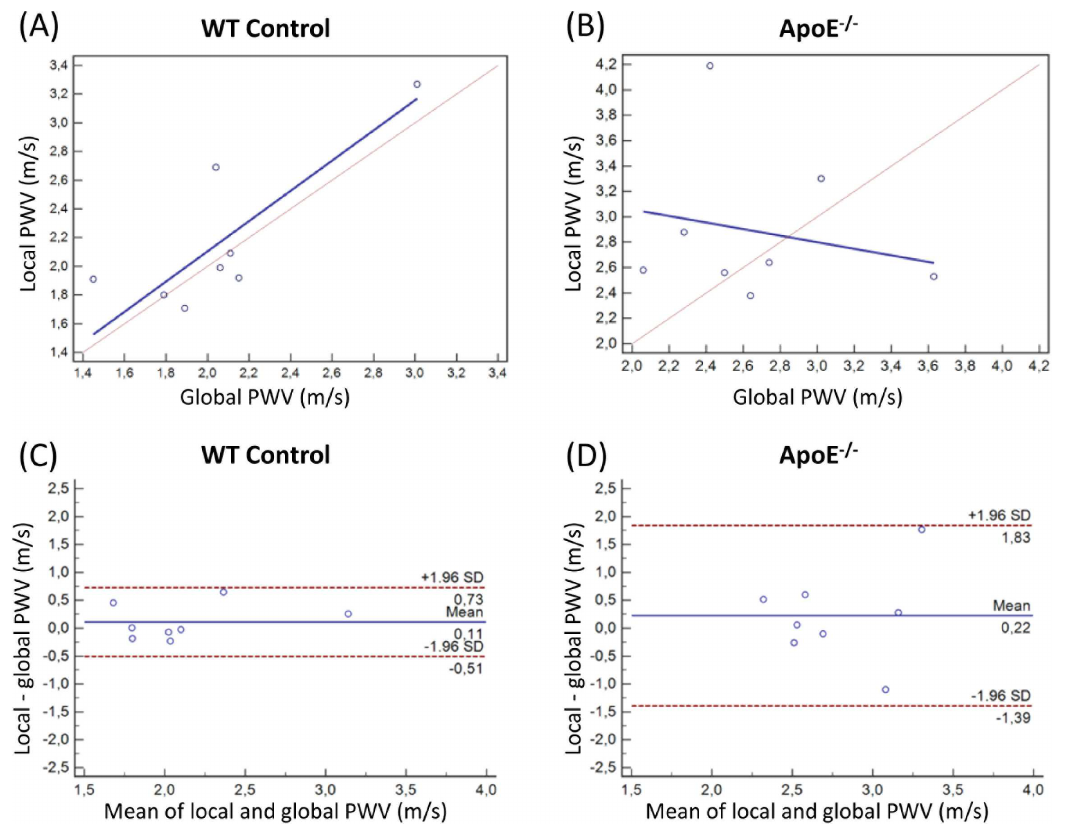
Fig 7. Correlation and agreementbetween global and local PWV in ApoE -/- and WT mice. Linearregression betweenglobalPWV values obtained with the multi-pointTT-method and the local PWV, assessedwith the QA-method for the WT group ( A ) and the ApoE -/- group ( B, blue: regression line, red: identity line). The Bland-Altman plots show that there is a higheragreementbetweenlocal and globalPWV in WT mice ( C ) as comparedto ApoE -/- mice ( D